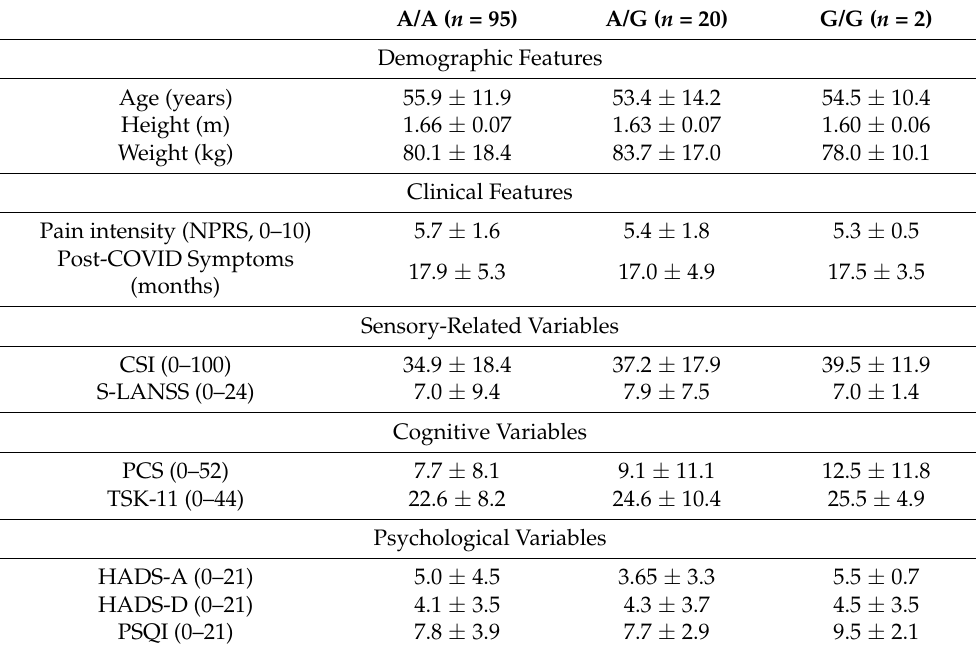
Table 5. Differences in pain phenotyping in COVID-19 survivors with post-COVID pain depending on the Interferon Induced Transmembrane 3 (IFITM3) polymorphism